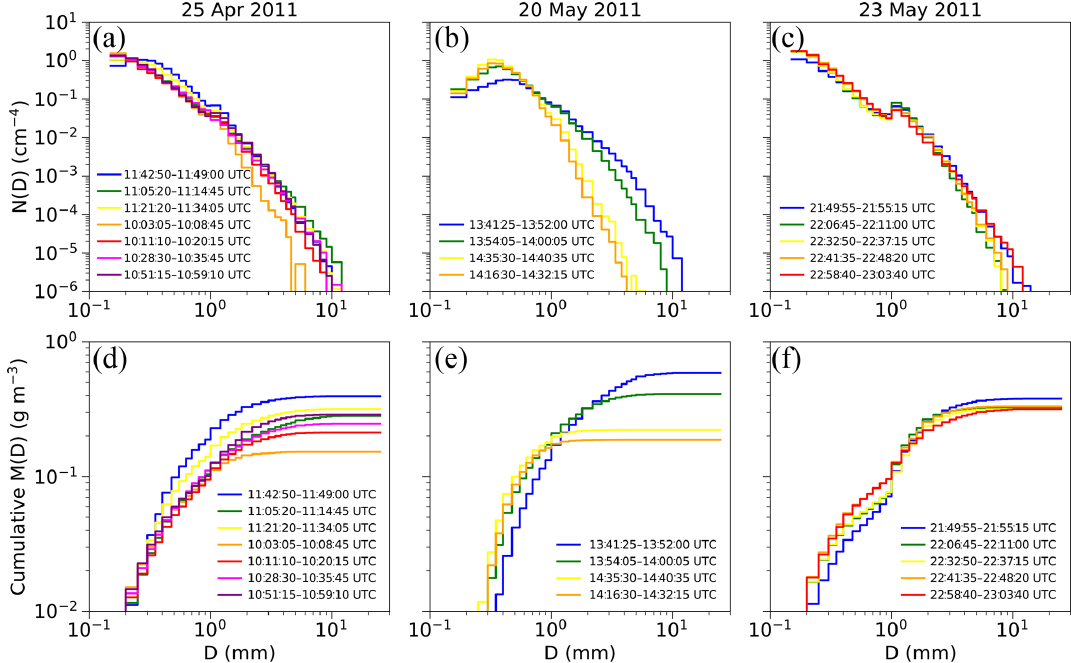
Figure 11. Mean N(D) (a, b, c) and cumulative M(D) (d, e, f) for each constant-temperature leg on 25 April (a, d) , 20 May (b, e) , and 23 May 2011 (c, f) . Cases where multiple legs of the same temperature exist are shown in chronological